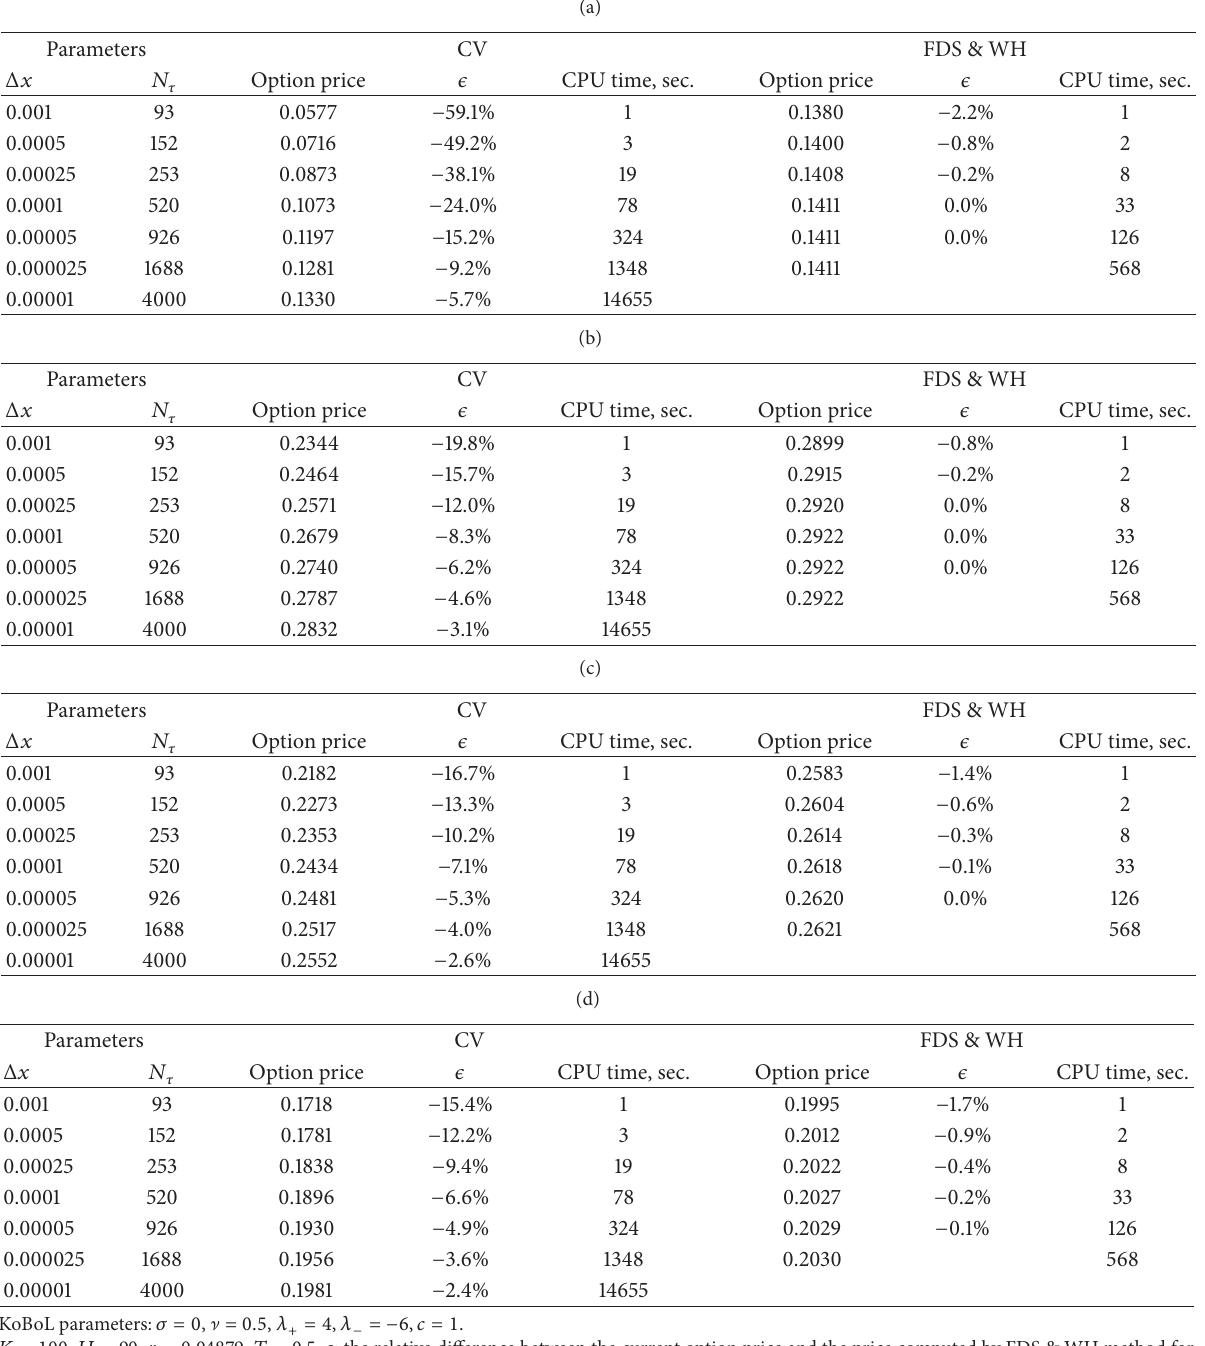
Table 1: Convergence of the down-and-out put prices in KoBoL model, ] < 1 : FDS & WH versus